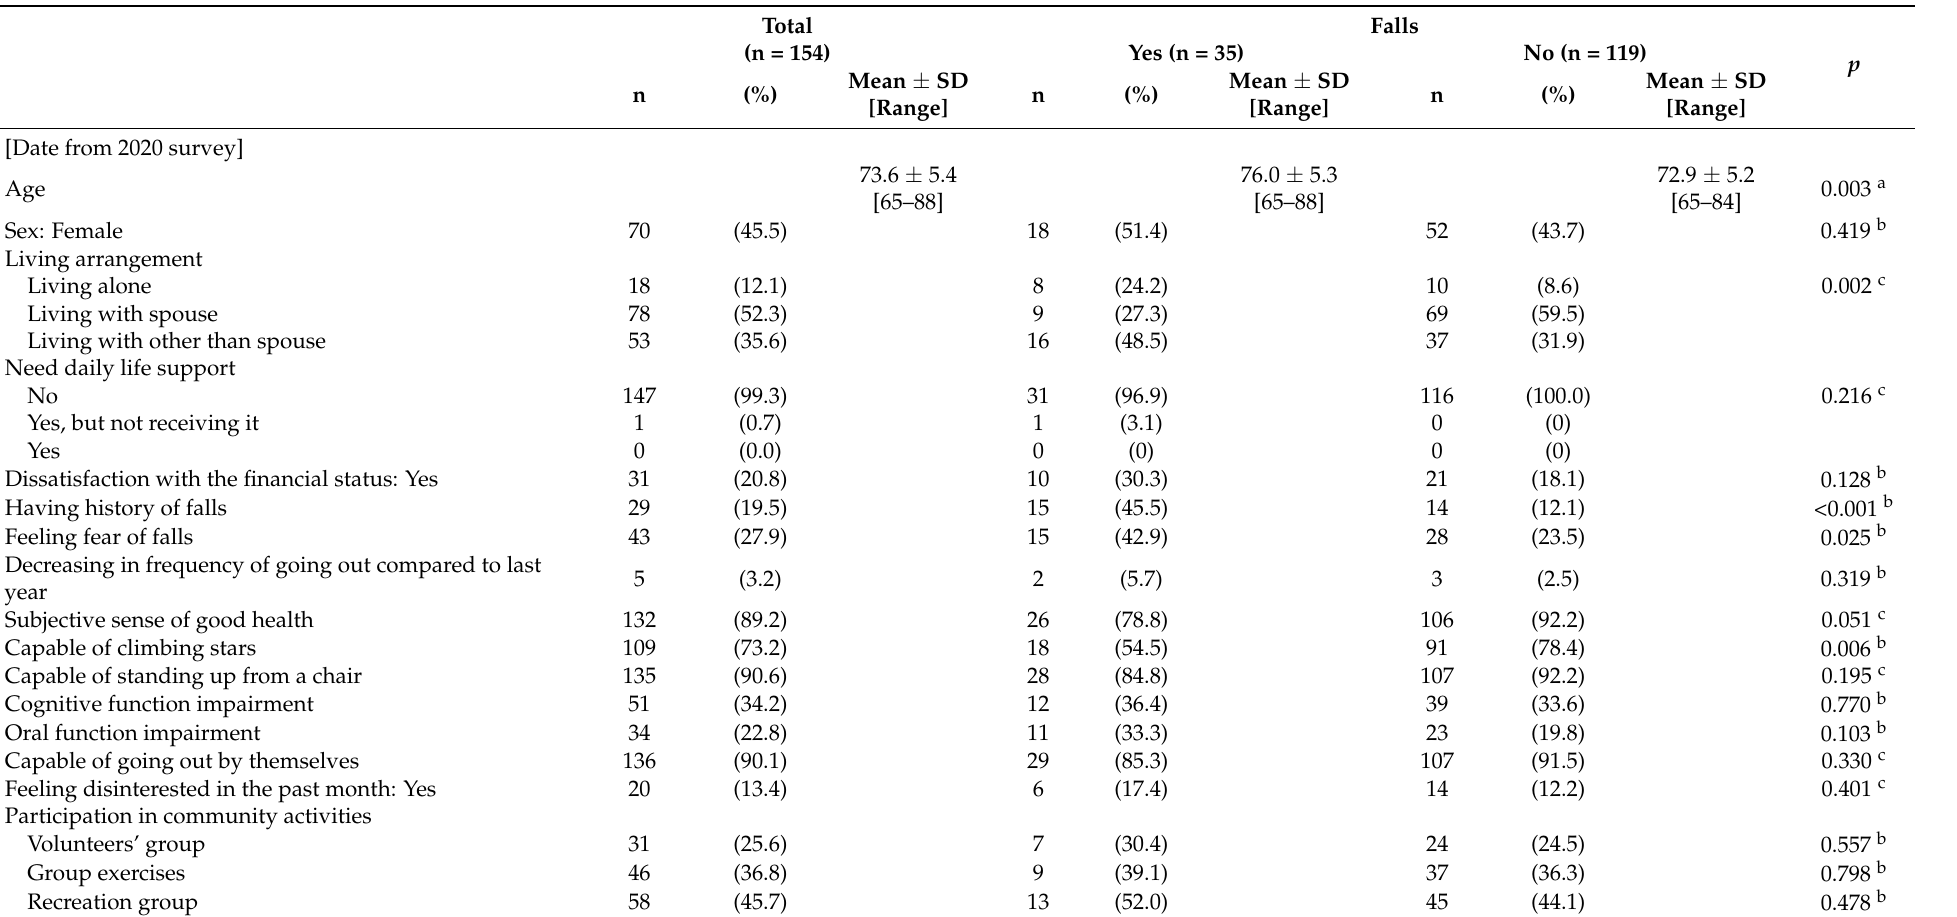
Table A1. Participants’ characteristics and their association with incidence of falls: Univariate analysis among who were going out at least five times a week pre-pandemic (n =